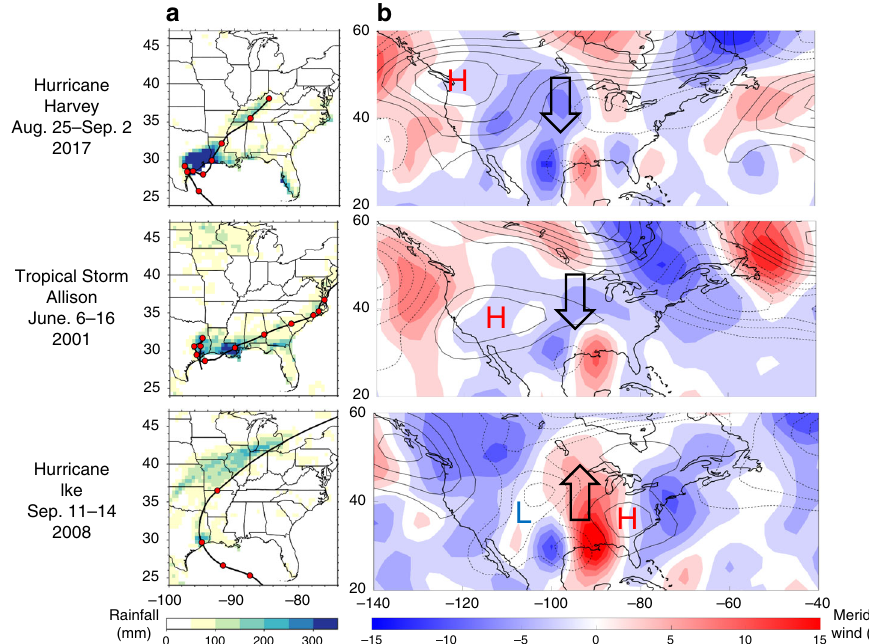
Fig. 1 Track, rainfall, and large-scale circulation. a The track of Hurricane Harvey, Tropical Storm Allison, and Hurricane Ike, and the rainfall (shading) during each storm. The red circles mark the position of the center of the storm at 9:00 a.m. UTC during the dates shown for each storm (data from International Best Track Archive for Climate Stewardship, version 4). The shading shows the cumulative rainfall during the time of each storm (Harvey: 25 Prediction Center). b The anomalous meridional steering wind (shading) and anomalous geopotential height at 500 mb (Z500, contour lines) on the day of Ike ’ s landfall (13 September 2008) and averaged over the day of landfall and the next two days for Harvey (26 – 28 August 2017) and Allison (6 – 8 June 2001). Data are from NCEP-DOE reanalysis. Due to Ike ’ s fast movement, the large-scale circulation is plotted only on the day of landfall. The anomalies are computed with respect to a 15-day (17-day) running mean around the landfall date (landfall date + 1) for Ike (Harvey and Allison) for 1979 – 2018, with the landfall year excluded. The interval of contour lines is 25 m and continuous (broken) lines show positive (negative) values. High-pressure (H) and low- pressure (L) systems are marked. See Methods for further